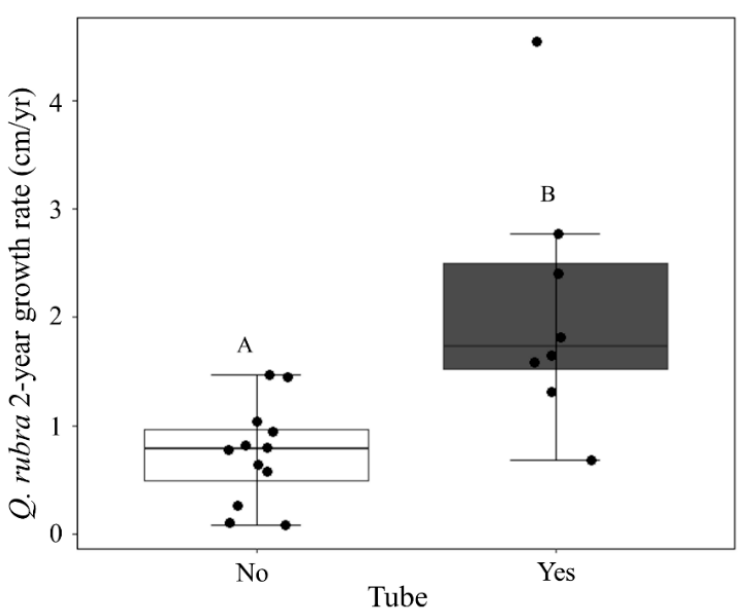
Figure 4. The growth rate of Q. rubra seedlings two years after planting by the use of tree tubes for seedlings planted in a temperate forest understory in southwestern Ohio, USA, during a forest restoration experiment. White indicates a lack of tree tube and dark grey indicates the use of tree tubes. Middle line in the box is the median, individual points represent seedlings, and letters represent statistically significant differences in the means ( p = 0.002).